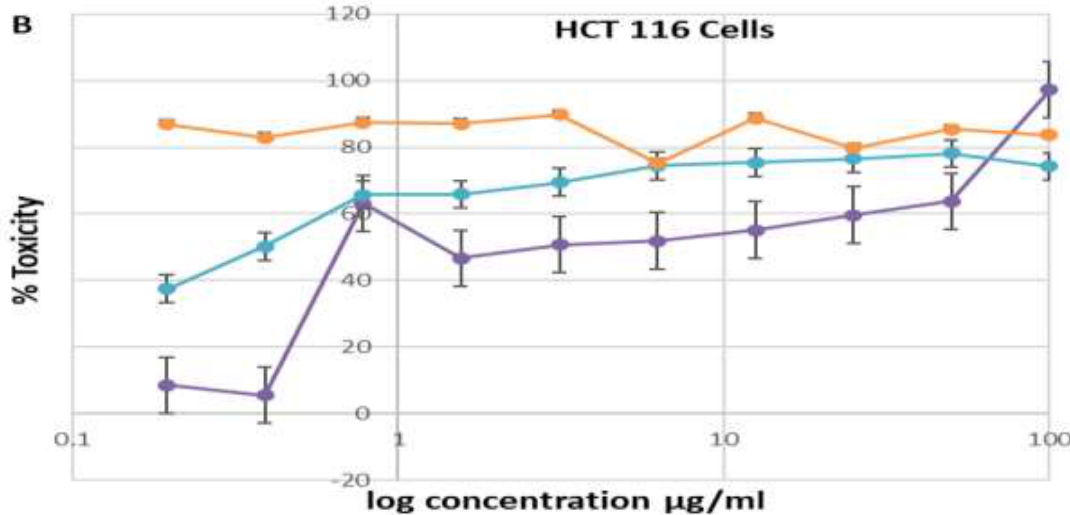
Figure 2. Log concentration versus toxicity of DOX , DOX+BA+RSV (1:1:1) and DOX+BA.IC 50 + RSV.IC 50 (non-fixed ratio) against HCT116 cells.